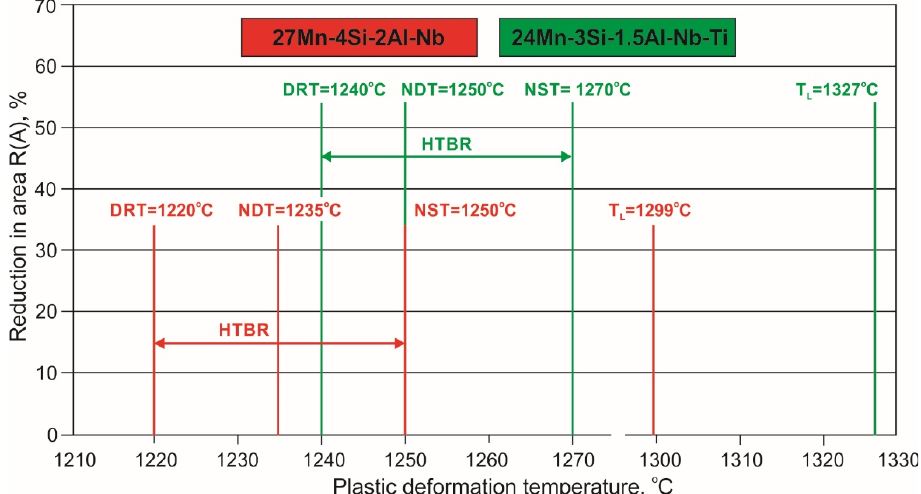
Figure 10. High-temperature plasticity characteristics and the high-temperature brittleness range (HTBR) of the tested steels.